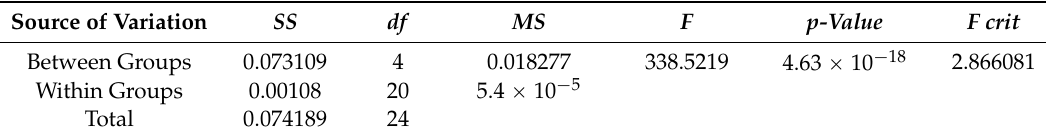
Table 2. Summary of gas sensor calibration results.